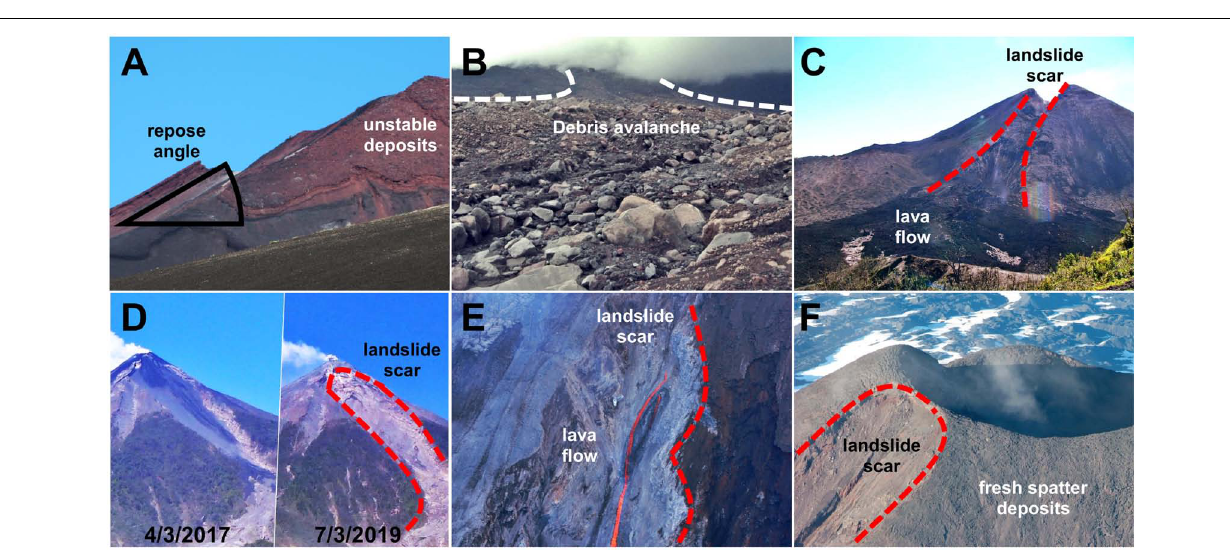
FIGURE 5 | Small landslides in mafic volcanoes. (A) Instable spatter and tephra fall deposits in the upper part of Lonquimay volcano, Chile; (B) Debris avalanche deposit produced by a landslide in Soputan volcano (October 2007), Indonesia; (C) Partial summit and gully collapse at Mackenney cone (Pacaya 2010, Guatemala) and at (D) Fuego volcano (2019; Guatemala); (E) Scar produced by the Sciara del Fuoco 2002 landslide in Stromboli (Italy); (F) Summit landslide of a spatter deposit in Llaima volcano (2008; Chile). Photo (A) by Jorge Romero, (B) by John Pallister, (C) by Gustavo Chigna, (D) by Alisa Naismith (E) by Mauro Coltelli and (F) by Daniel